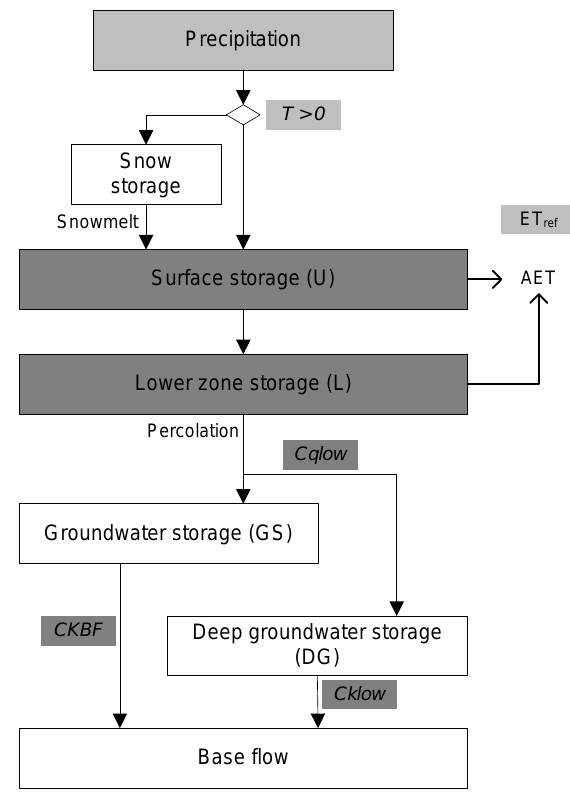
Fig. 3. Structure of the rainfall-runoff model. Items on light shad- ing are input data, those on dark shading relate to the calibration